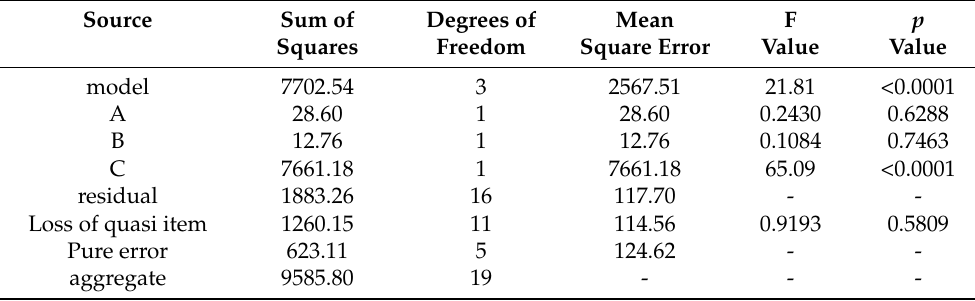
Table 5. Results of regression analysis of variance of tensile strength index.